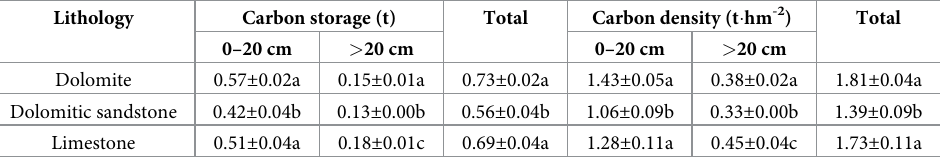
Table 9. Carbon storage (400 m 2 ) and organic carbon density in bare ground soils under different lithologies.